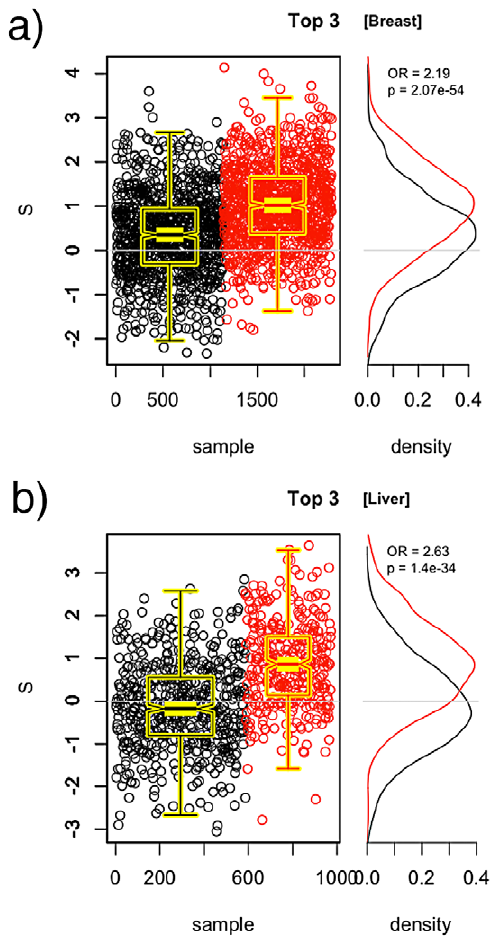
Figure 5. Union of top three pathways. SNPs from the top three pathways are combined to compute S for the breast cancer data (a) and the liver cancer data (b). Distributions of S for cases (red) and controls (black) are given to the right. A significant shift toward higher S values is seen in the cases.